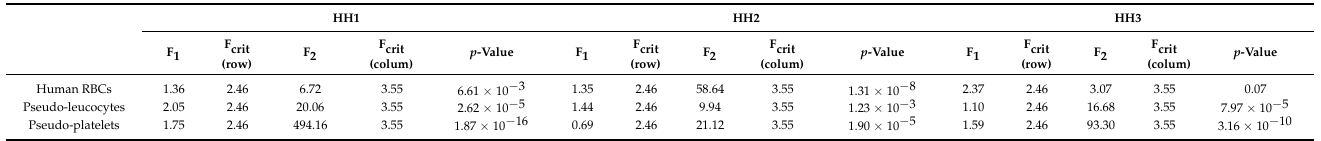
Table 4. The results of statistical analysis between different